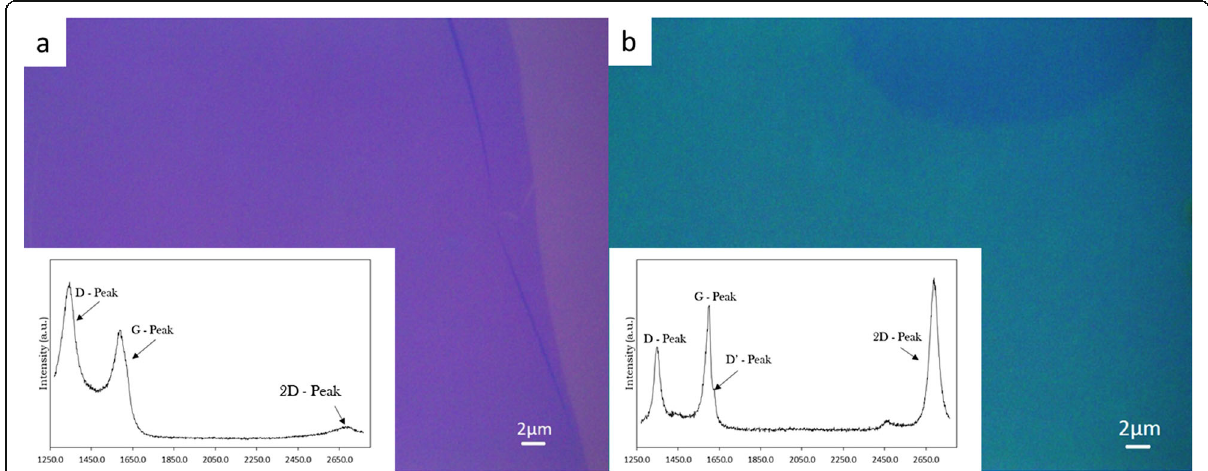
Fig. 2 Optical images and Raman spectra (inserts) of a amorphous carbon as the result of an attempted graphene synthesis for 7 min C 2 H 2 exposure on 50 nm pure Ni catalyst at 450 °C and b successful graphene synthesis following the same parameters as a on codeposited Ni-Au catalyst, please note the dark spot in the top of image b is an area of multilayer graphene and was captured to add contrast to help identify the surrounding monolayer area. There is an obvious improvement created by the addition of 1 wt% Au as this is the only variable changed to allow for the drastic shift from amorphous carbon to graphene. Labeled in a are the key peaks used for graphene characterization. For b , we calculate I